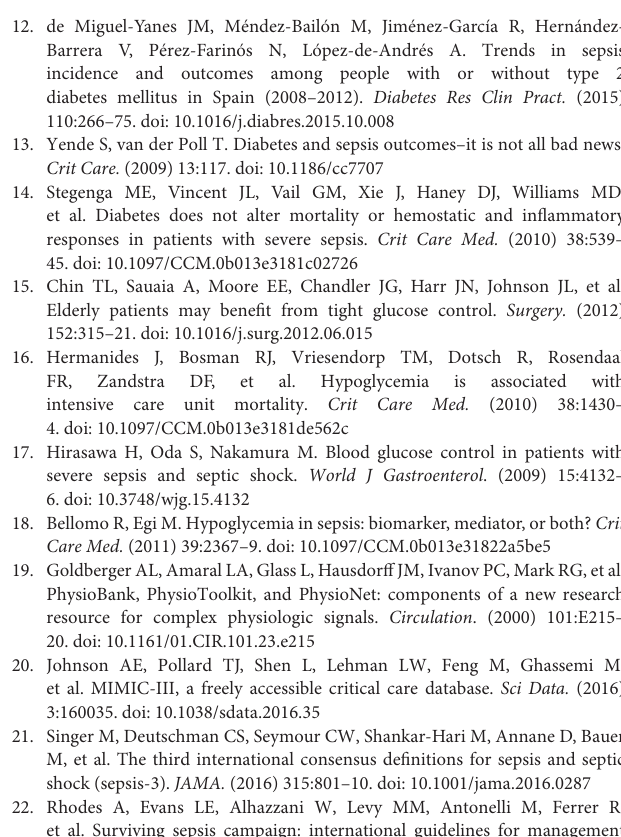
Supplementary Figure 1 | Kaplan-Meier curves for 30-day survival probability in septic patients, according to the admission indicators. (A) SOFA score; (B) platelet; (C) serum creatinine; (D) lactic acid; (E) blood urea nitrogen; (F) alanine aminotransferase; (G) age; (H) anion gap; (I) total bilirubin; (J) blood glucose. SOFA, the Sequential Organ Failure Assessment. Supplementary Figure 2 | Kaplan-Meier curves for 30-day survival probability in septic patients without known diabetes, according to the admission indicators. (A) blood glucose; (B) SOFA score; (C) lactic acid; (D) other race; (E) platelet; (F) serum creatinine; (G) hemoglobin; (H) total bilirubin; (I) blood urea nitrogen; (J) alanine aminotransferase; (K) aspartate aminotransferase; (L) age; (M) anion gap; (N) white blood cell. SOFA, the Sequential Organ Failure Assessment. Supplementary Table 1 | The demographic characteristics of sepsis patients in the present